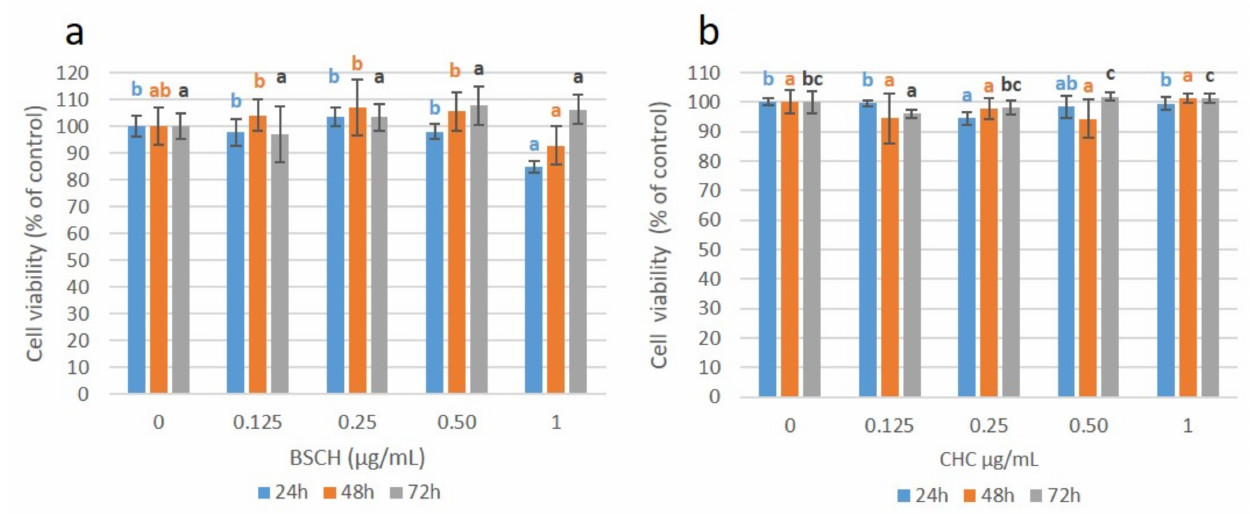
Figure 4. Cell viability values (%) for the fibroblast cell cultures treated with BSCH ( a ) and CHC ( b ) hydrolysates and normalized to the control group. Values are shown as means with standard deviation. Different letters indicate a significant difference between concentration groups ( p <